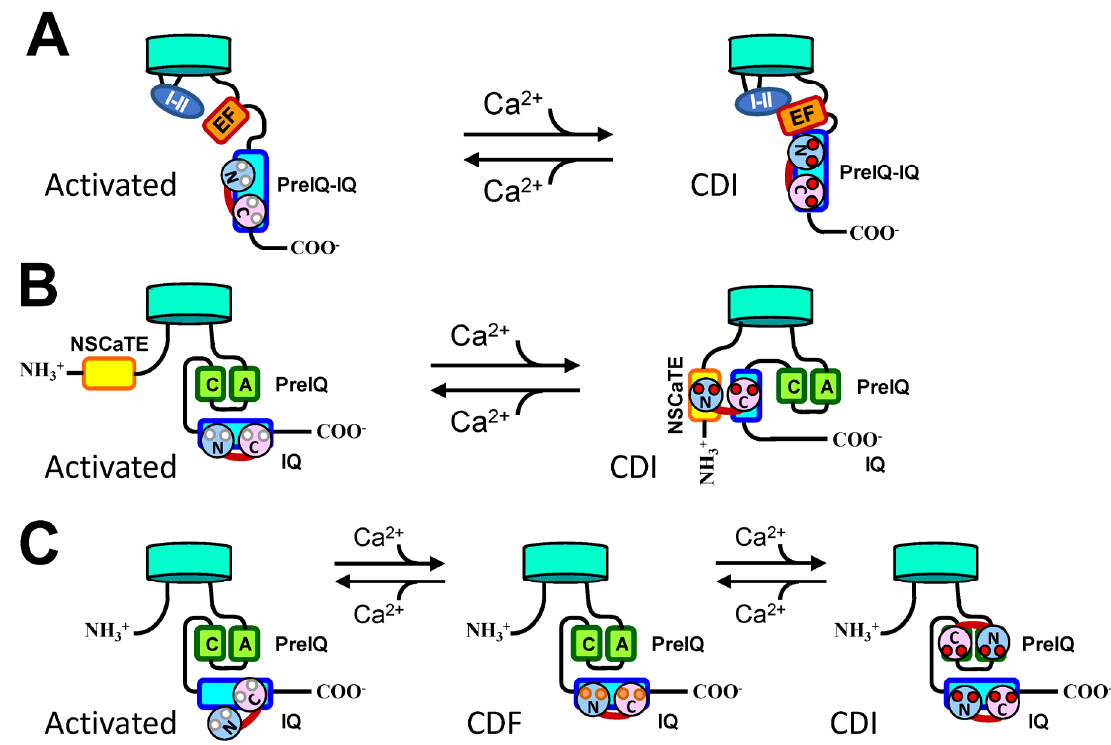
Figure 3. Models for CDI and CDF. ( A ) CDI model of Kim et al. [97]. Ca 2+ binding to CaM, which is tethered to the preIQ-IQ region of the channel, induces a conformation change that initiates interaction with the EF-hand region, resulting in further interaction with the I–II loop, leading to CDI. ( B ) CDI model of Yue’s group [98]. Ca 2+ binding to CaM induces bridging between the N- and C-ter- mini, leading to CDI. ( C ) ‘Two CaM hypothesis’ [43,51,99]. At resting conditions, a fraction of chan- nels are bound by CaM and the rest are CaM-free (low activity). ( A ) moderate increase in [Ca 2+ ] increases the fraction of CaM-bound channels (high activity), leading to CDF. A further increase in [Ca 2+ ] induces binding of the second Ca 2+ /CaM to the putative inactivation site, resulting in CDI. CaM’s N-lobe (light blue) and C-lobe (pink) with Ca 2+ -free (white circles) and partially Ca 2+ -satu- rated (pink circles) and Ca 2+ -saturated (red) EF-hand domains are illustrated. Other abbreviations are the same as those in Figure 1. Reported [CaM] free in resting cardiac myocytes (100 nM [Ca 2+ ]) are 50–75 nM, repre- senting only 1% of the total (free + bound to cellular constituents) [CaM] [45,100]. There- fore, CaM-bound Cav1.2 channels at the resting condition (i.e., [CaM] free = 200 nM, consid- ered a high [CaM] in Z-line area [45]) and [Ca 2+ ] = 100 nM) represent approximately 10% of the total number of channels in the cell-free patches [51]. Thus, the potential dynamic range of the CaM-mediated CDF may be larger from a design point of view than consid- ered thus far. Interestingly, the maximum e ff ects of CaM 12 and CaM 34 were reduced as [Ca 2+ ] increased [96]. A similar phenomenon was observed with WT CaM, suggesting that another Ca 2+ sensor might exist in addition to CaM [51]. It is of note that the concentration of the intracellular Mg 2+ shows biphasic e ff ects on I Ca , facilitation and inactivation, similar to Ca 2+ [101]. It may be interesting to explore if the Mg 2+ e ff ects are mediated by CaM. 2.4.5. Mutations that A ff ect CDF Numerous studies suggest that the IQ domain mutations in full-length channels can eliminate CDI and CDF [41,42,92,102,103]. Thus, it will be interesting to establish how CaM regulates VGCCs other than Cav1.2 through its interactions with their IQ motifs (re- viewed elsewhere [11,15,104–106]. The Cav1.2 IQ domain residues F1618, Y1619, and F1622 (rabbit) are involved in the interaction with the N-lobe of Ca 2+ /CaM, and triple-